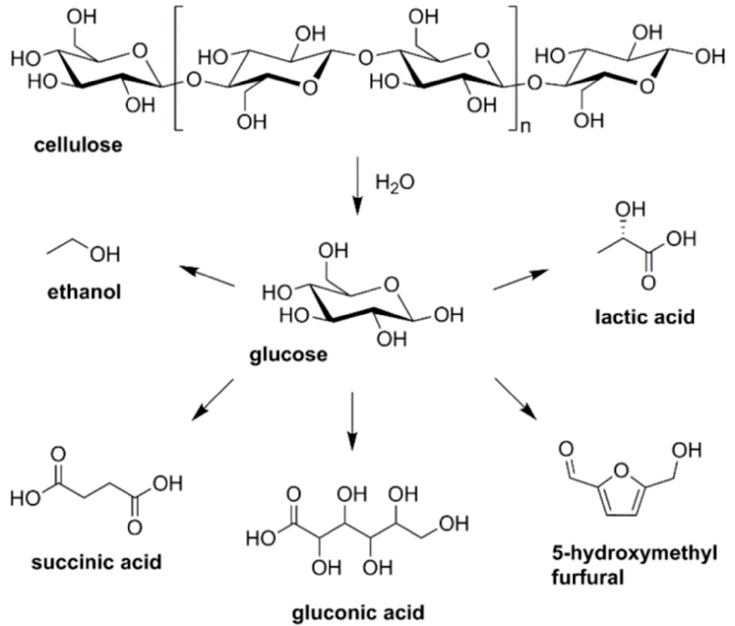
Figure 14. Proposed scheme for cellulose hydrolysis reaction showing some of the products that can be obtained by glucose transformation. Reproduced with permission from ref. [135] Copyright © 2019 John Wiley and Sons.